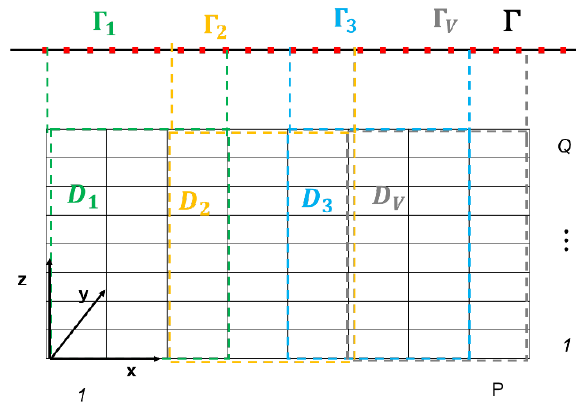
Figure 5. Shift and Zoom Algorithm description.